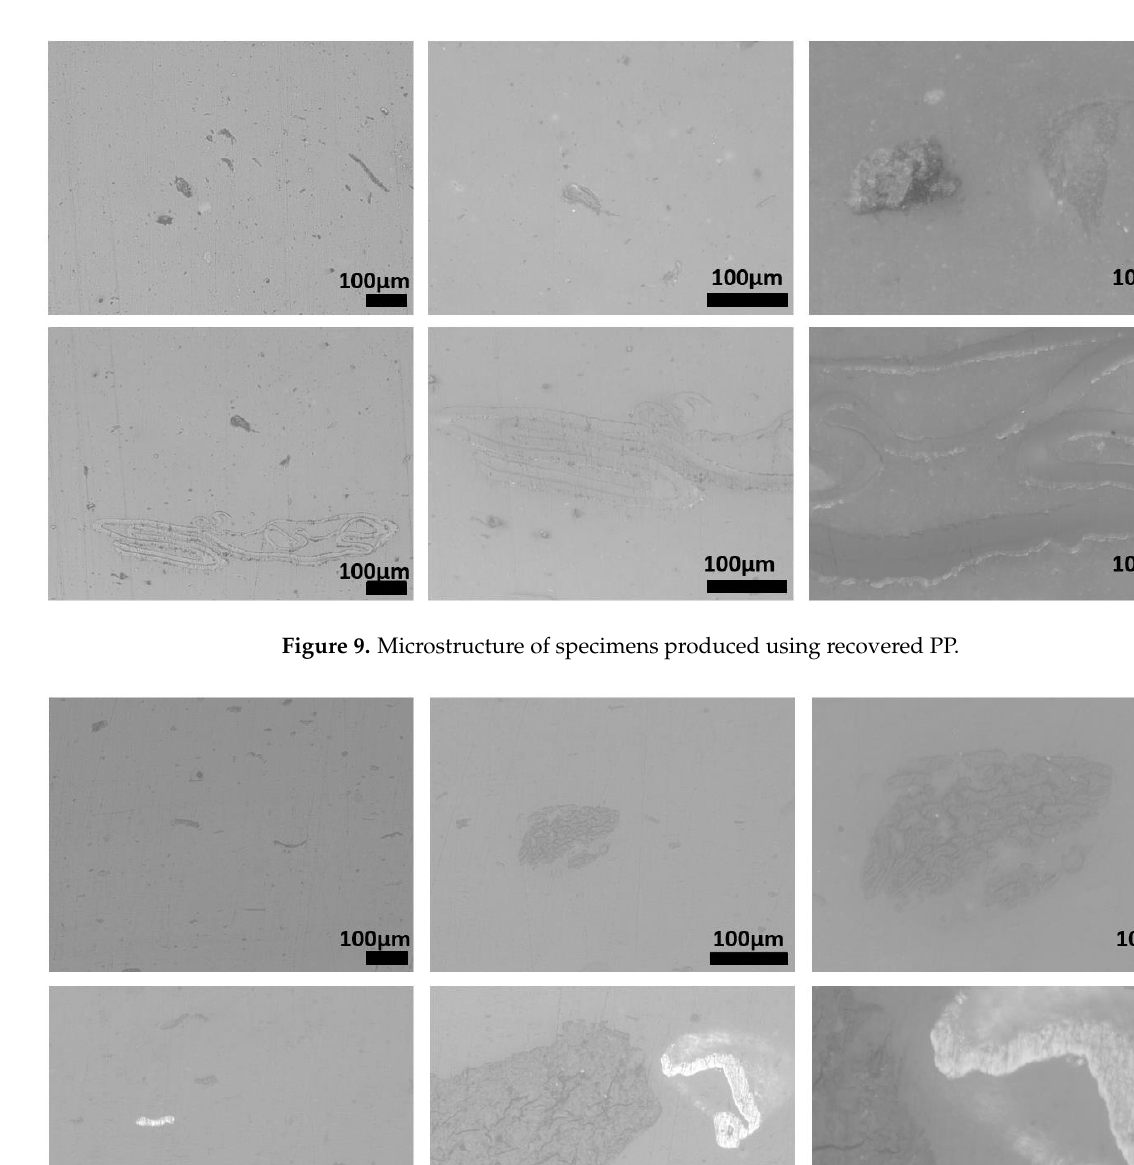
Figure 8. Microstructure of specimens produced using recovered PE.